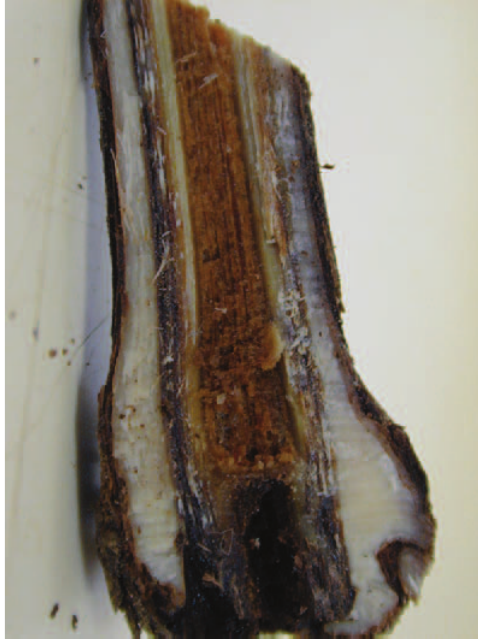
Fig. 4. Cross-section of an infected